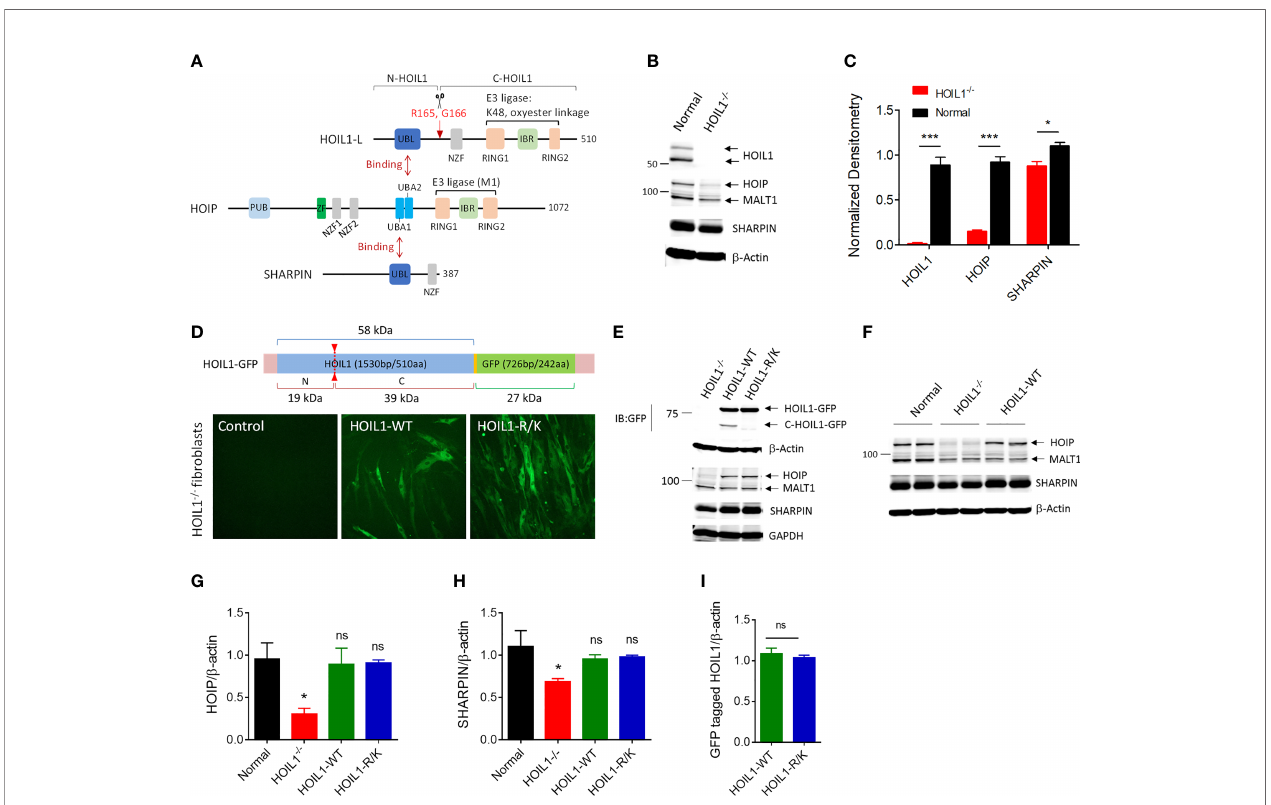
FIGURE 1 | Construction and characterization of human cells expressing a MALT1-resistant non-cleavable HOIL1 (HOIL1-R/K). (A) A schematic diagram illustrating the structural domains of HOIL1-L, HOIP and SHARPIN forming the LUBAC. HOIL1-L, active isoform of HOIL1 in the LUBAC, is cleaved at R165 by MALT1 to produce N- and C-terminal fragments, N-HOIL1 and C-HOIL1, respectively. The UBL domain of HOIL1 binds to the UBA2 domain of HOIP, whereas the UBL domain of SHARPIN binds to the UBA1 domain of HOIP, forming a stable trimolecular complex. (B) Representative immunoblots showing the expression levels of HOIL1, HOIP, SHARPIN and MALT1 in control and HOIL1-de fi cient (HOIL1 – / – ) human fi broblasts. (C) Normalized (to b -actin) densitometry analyses of HOIL1, HOIP and SHARPIN protein levels from (A) ( N ≥ 3). (D) Top: schematic representation of the HOIL1-GFP constructs used. Bottom: micrographs demonstrating transduction of GFP-tagged wild-type (WT) or non-cleavable (R/K) HOIL1 in HOIL1 – / – human fi broblasts. (E) Immunoblots showing transduction of different HOIL1- GFP constructs affecting HOIL1 cleavage capability and expression of HOIP, SHARPIN, and MALT1. (F) Immunoblots demonstrating the in fl uence of HOIL1 expression on the stability of the other LUBAC components HOIP and SHARPIN compared to normal human fi broblasts. b -actin as the internal control. (G, H) Densitometry quanti fi cation of HOIP (G) and SHARPIN (H) levels in the four conditions: normal fi broblasts, HOIL1 – / – fi broblasts, HOIL1 – / – fi broblasts expressing HOIL1-WT and HOIL1 – / – fi broblasts expressing HOIL1-R/K ( N ≥ 3). (I) Densitometry quanti fi cation of GFP-tagged HOIL1-WT and HOIL1-R/K expressed in HOIL1 – / – fi broblasts after transduction ( N ≥ 3). *p < 0.05, ***p < 0.001, ns, non-signi fi cant relative to control unless otherwise